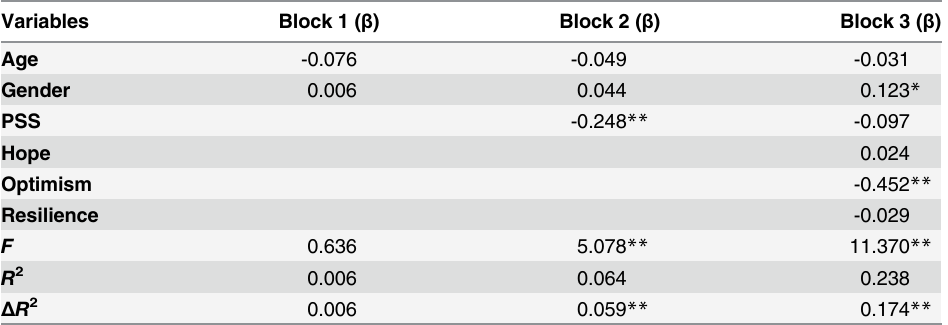
Table 4. Hierarchical regression for exploring the positive correlates of PTSD